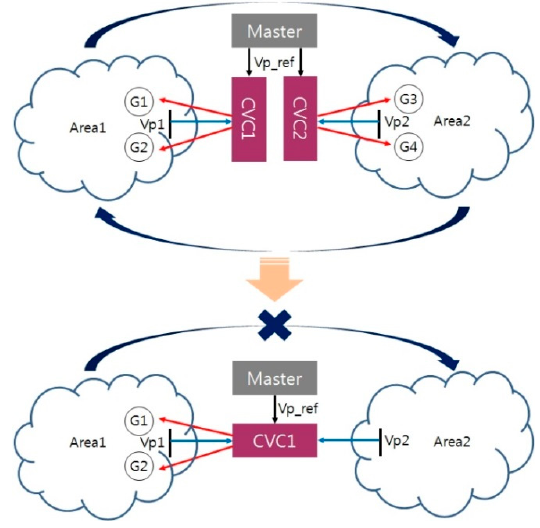
Figure 2. Multiple-point control algorithm concept.